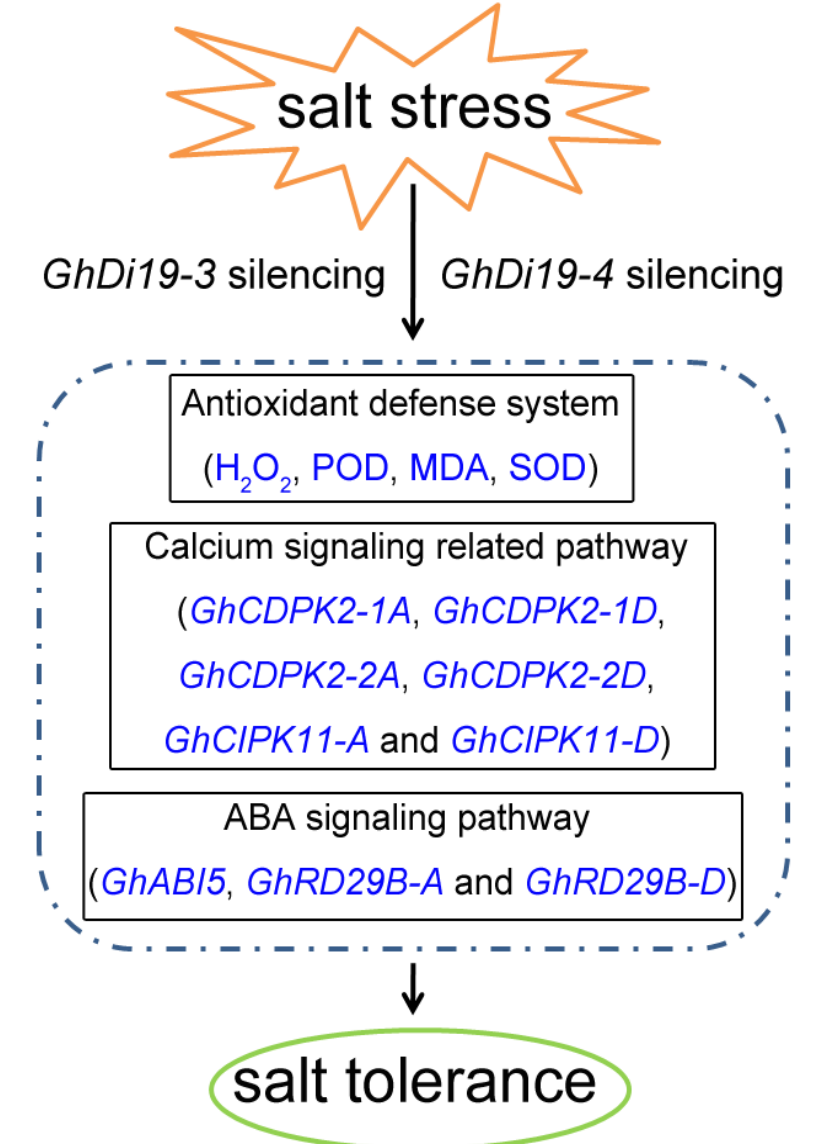
Figure 8. A model describing the silenced GhDi19-3 and GhDi19-4 gene regulates cotton tolerance to salt stress. GhDi19-3 and GhDi19-4 were up-regulated under salt stress, and the silencing of GhDi19-3 or GhDi19-4 genes led to a change in up- and down-regulation of calcium signaling and ABA signaling pathway related genes ( GhCDPK2-1A , GhCDPK2-1D , GhCDPK2-2A , GhCDPK2-2D , GhCIPK11-A , GhCIPK11-D , GhABI5 , GhRD29B-A , and GhRD29B-D ), which then resulted in their abilities improving to effectively reduce the ROS damage when cotton plants were subject to salt stress. Taken together, GhDi19-3 and GhDi19-4, as two negative regulatory transcription factors, responded to salt stress by being involved in calcium signaling and ABA signaling pathways.